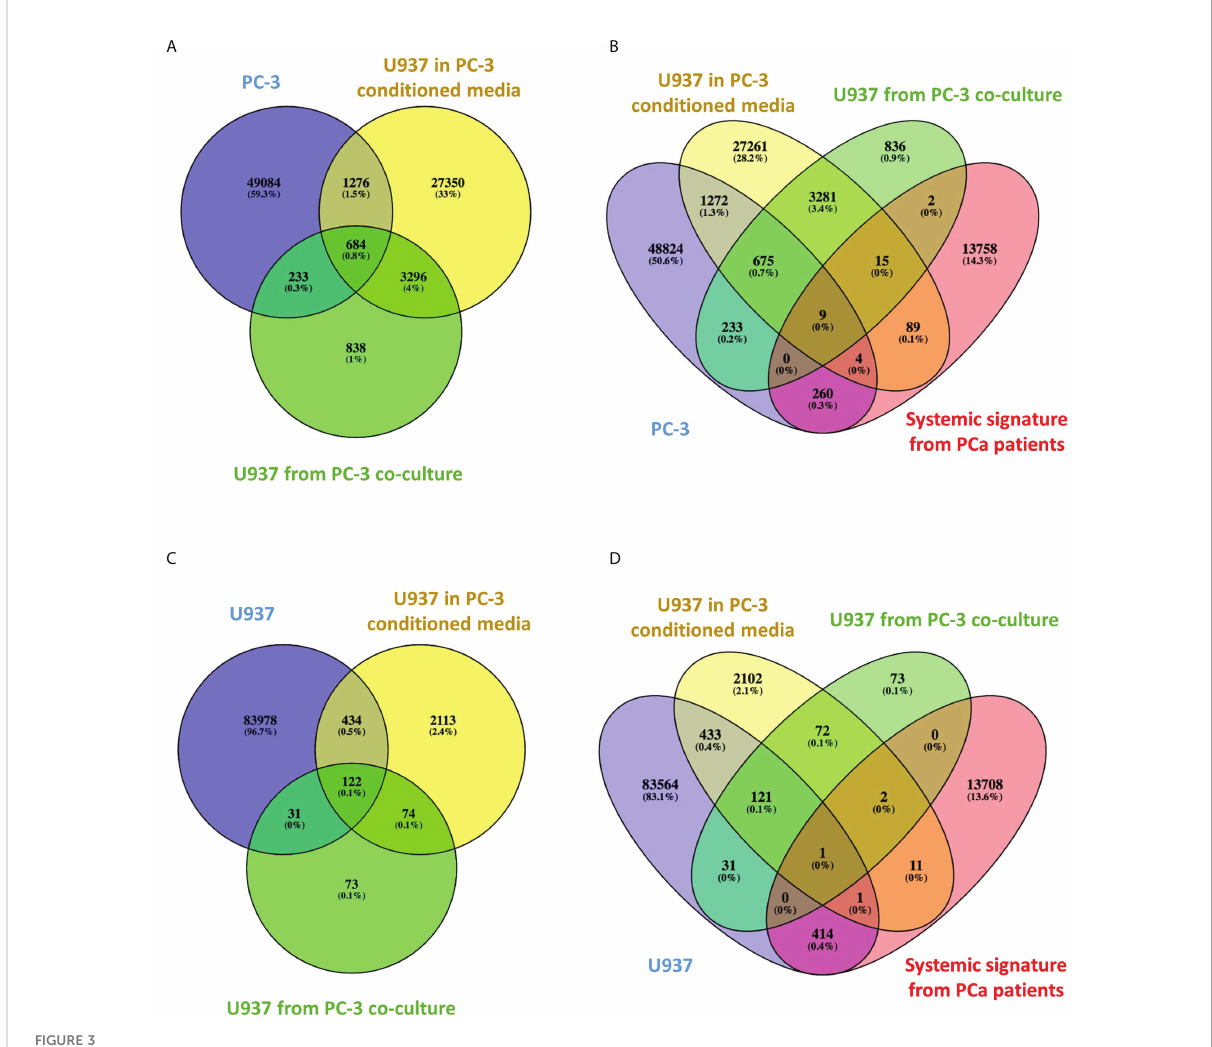
FIGURE 3 Venn diagrams of CCSs overlap between treatment groups and high-risk PCa patients. (A – D) . Venn diagrams indicating the number of overlapping CCSs between various